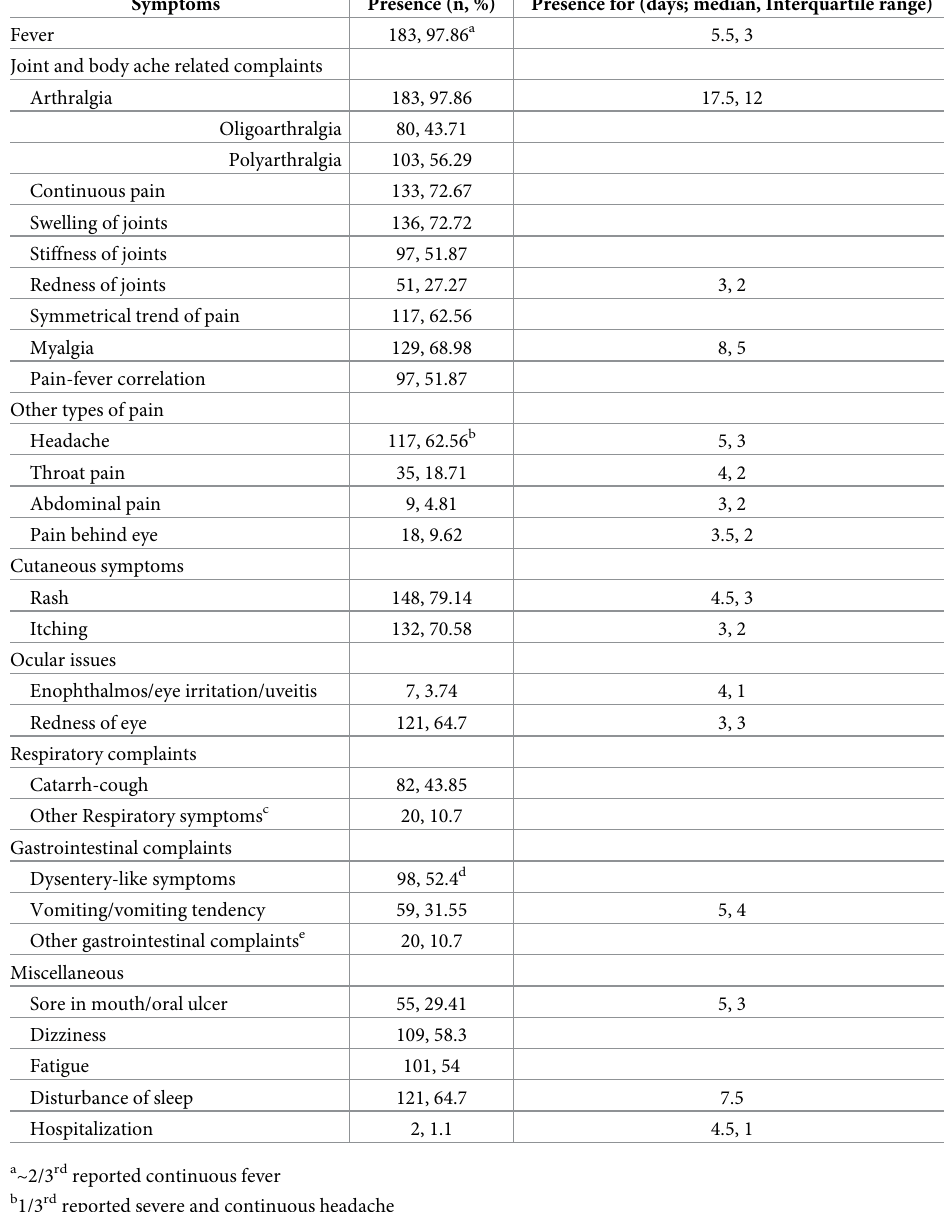
Table 3. Signs and symptoms recorded from CHIKV positive patients during the acute phase. Symptoms Presence (n, %) Presence for (days; median, Interquartile